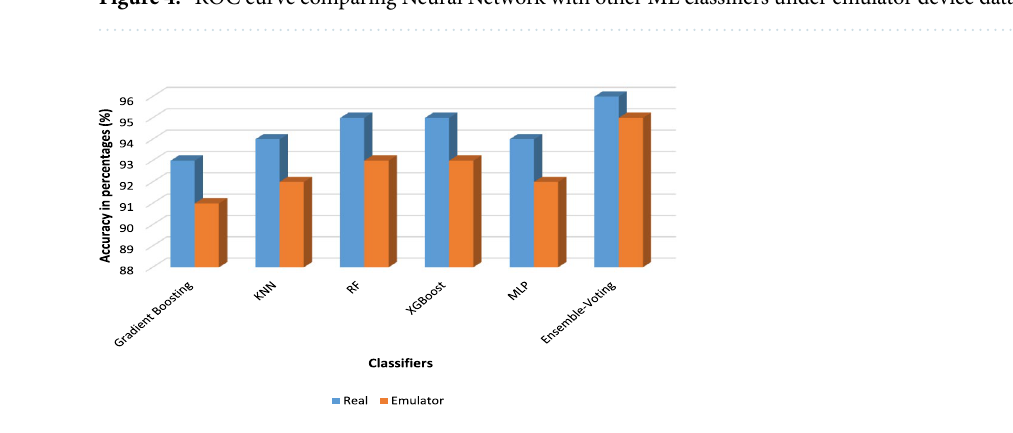
Figure 5. Accuracy comparing Neural Network with others under emulator and real device